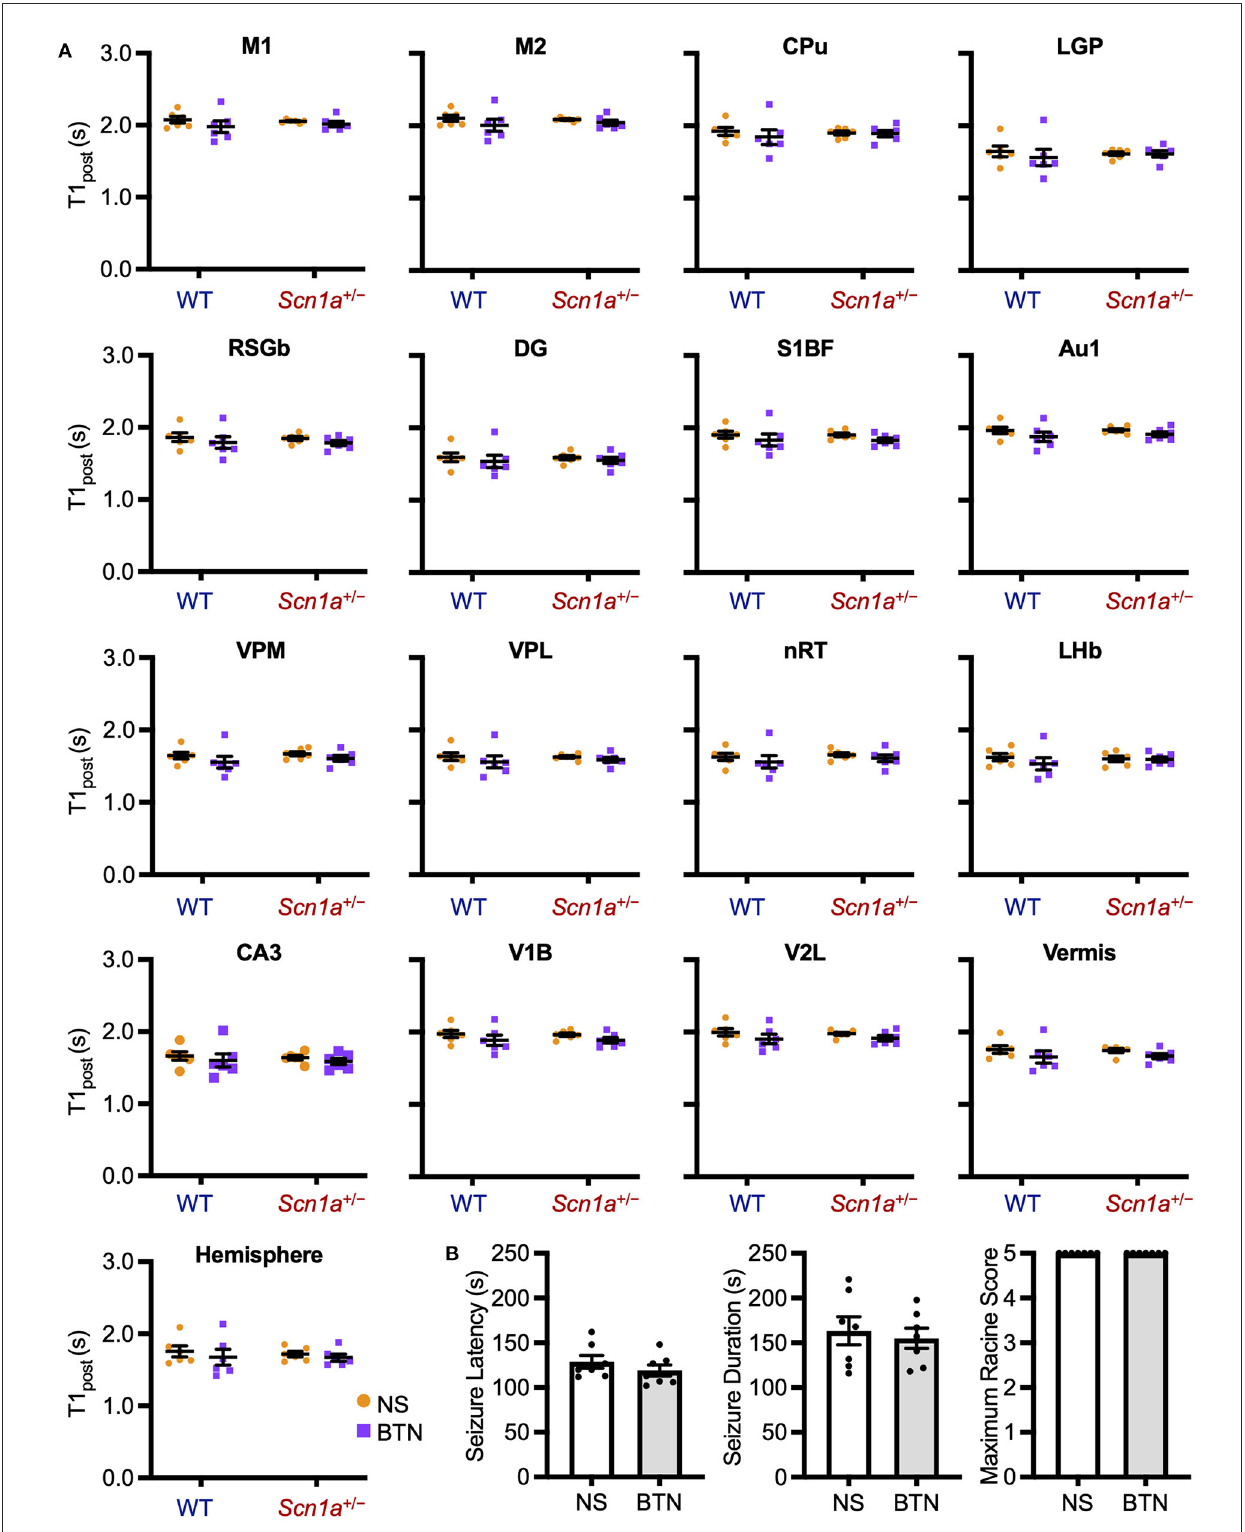
FIGURE5 T1 post at P27 of wild-type and Scn1a + / − rats after administration of BTN or NS. (A) Tukey multiple-comparison test of T1 post in rats at P27 after administration of BTN (orange circle) or NS (purple square). There was no significant difference in T1 post between BTN-treated and NS-treated Scn1a + / − rats. n = 6 per group (Tukey multiple-comparison test). Data are presented as mean ± SEM. (B) Comparison of seizure latency, seizure duration, and seizure score of Scn1a + / − rats at P27 between the BTN-treated and NS-treated groups. BTN did not affect the seizure characteristics at P27. n = 7 per group, Mann–Whitney U test. Data are presented as mean ± SEM. BTN, bumetanide; NS, normal saline; P, postnatal day; SEM, standard error of the